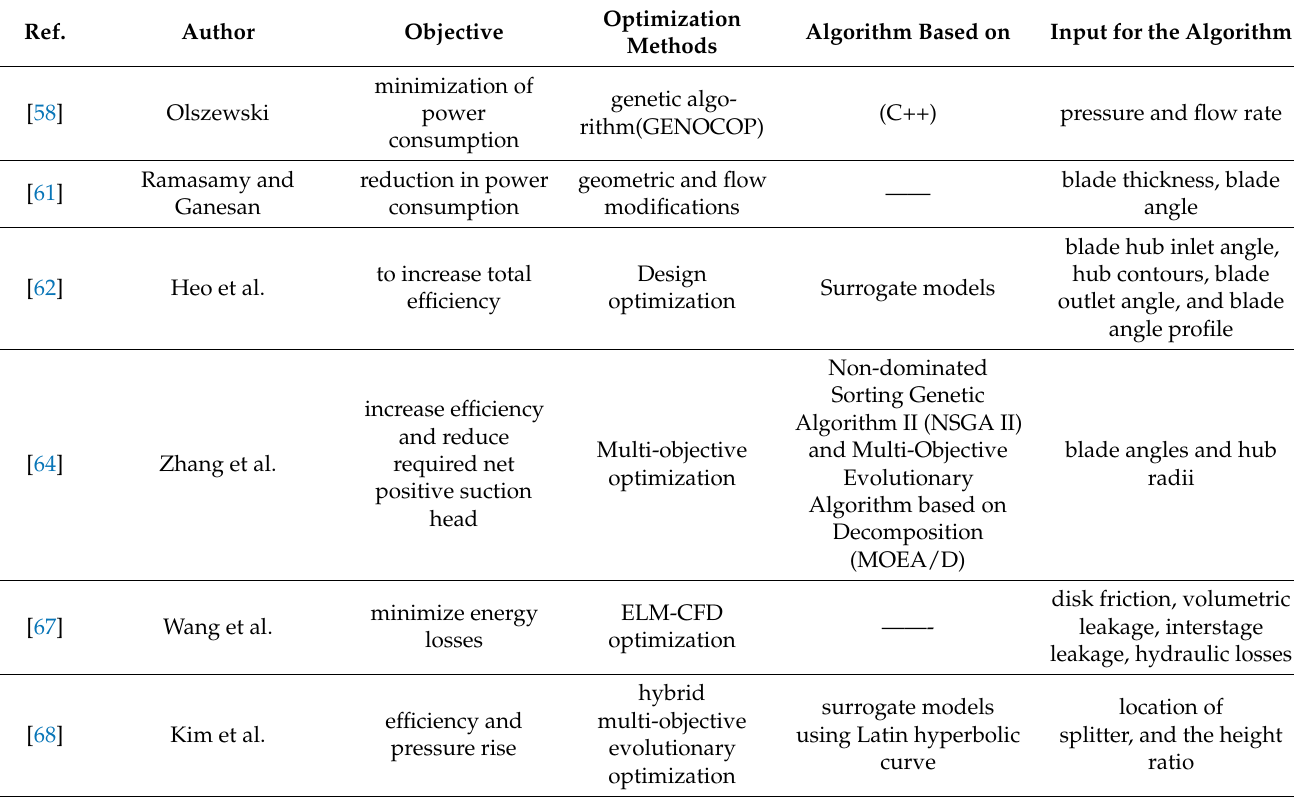
Table 2. Optimization methods utilized for various